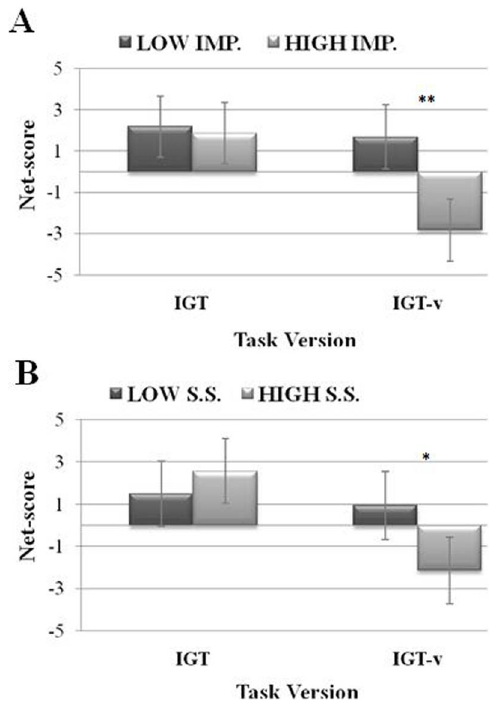
Figure 2. Net scores as a function of IGT version for Impulsivity and Sensation Seeking levels. Mean net scores in the original (IGT) and modified (IGT-v) task versions for participants with Low vs. High Impulsivity levels (A) and participants with Low vs. High Sensation Seeking levels (B). Vertical bars denote + / 2 0.95 confidence intervals, * p # 0.05, ** p # 0.01.